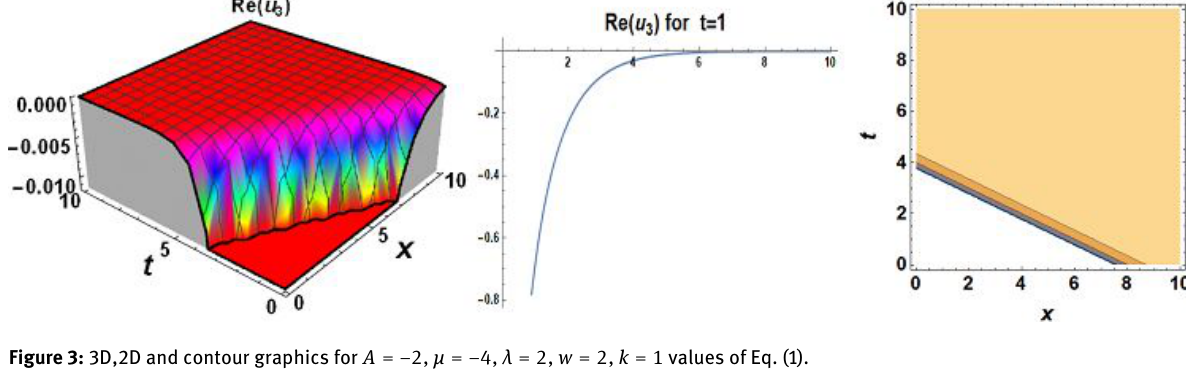
Figure 3: 3D,2D and contour graphics for A = −2, µ = −4, λ = 2, w = 2, k = 1 values of Eq. (1).